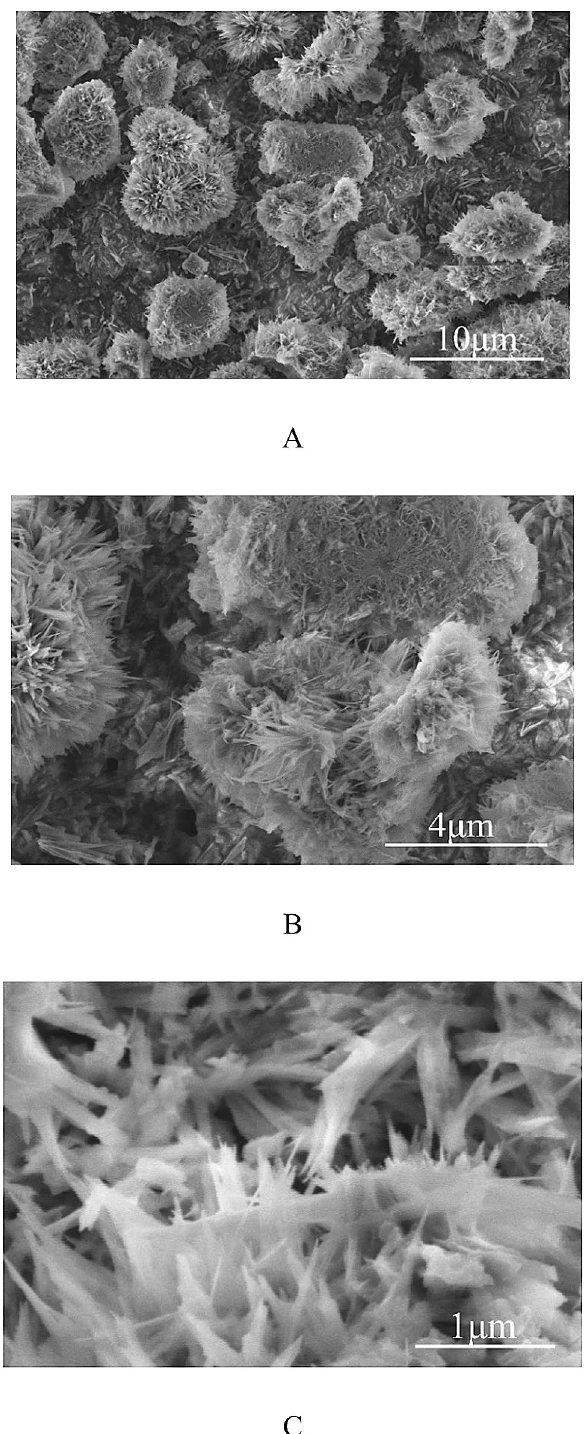
Figure 2. SEM image of the omniphobic, icephobic surface is supplied. ( A ) Scale bar is 10 μm. ( B ) Scale bar is 4 μm. ( C ) Scale bar is 1 μm. The very similar topographies were registered for the surfaces obtained with the dip—coating and spraying